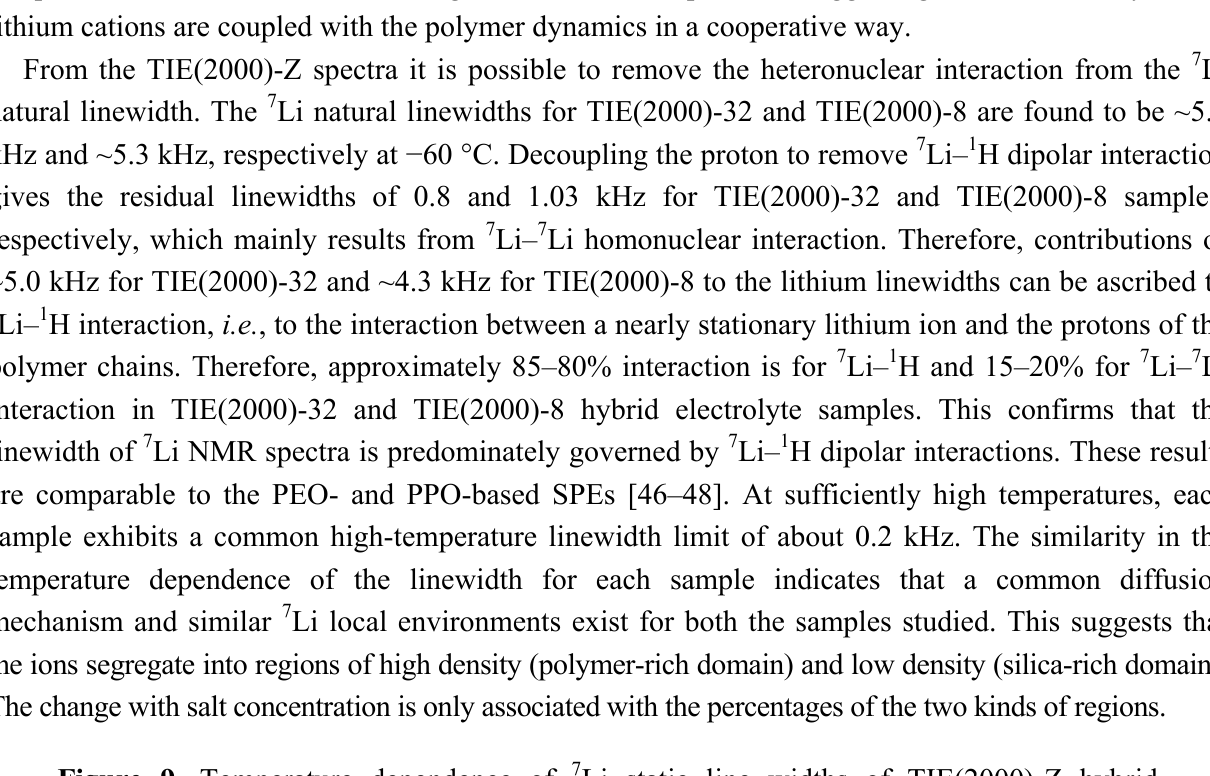
Figure 9. Temperature dependence of 7 Li static line widths of TIE(2000)-Z hybrid and (b) with proton decoupling. The dashed lines represent the T